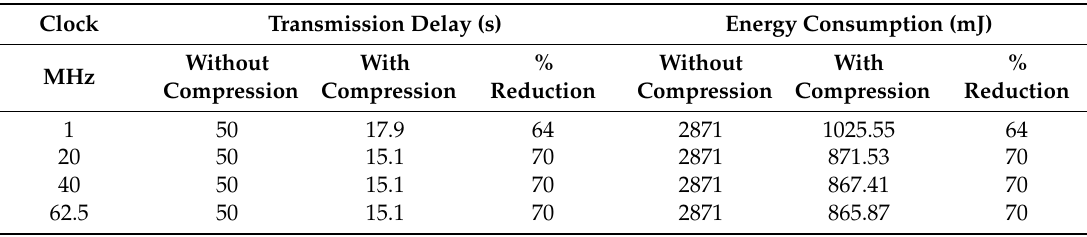
Table 9. Energy and delay reduction for ECG_EkgMove using shimmer 802.15.4